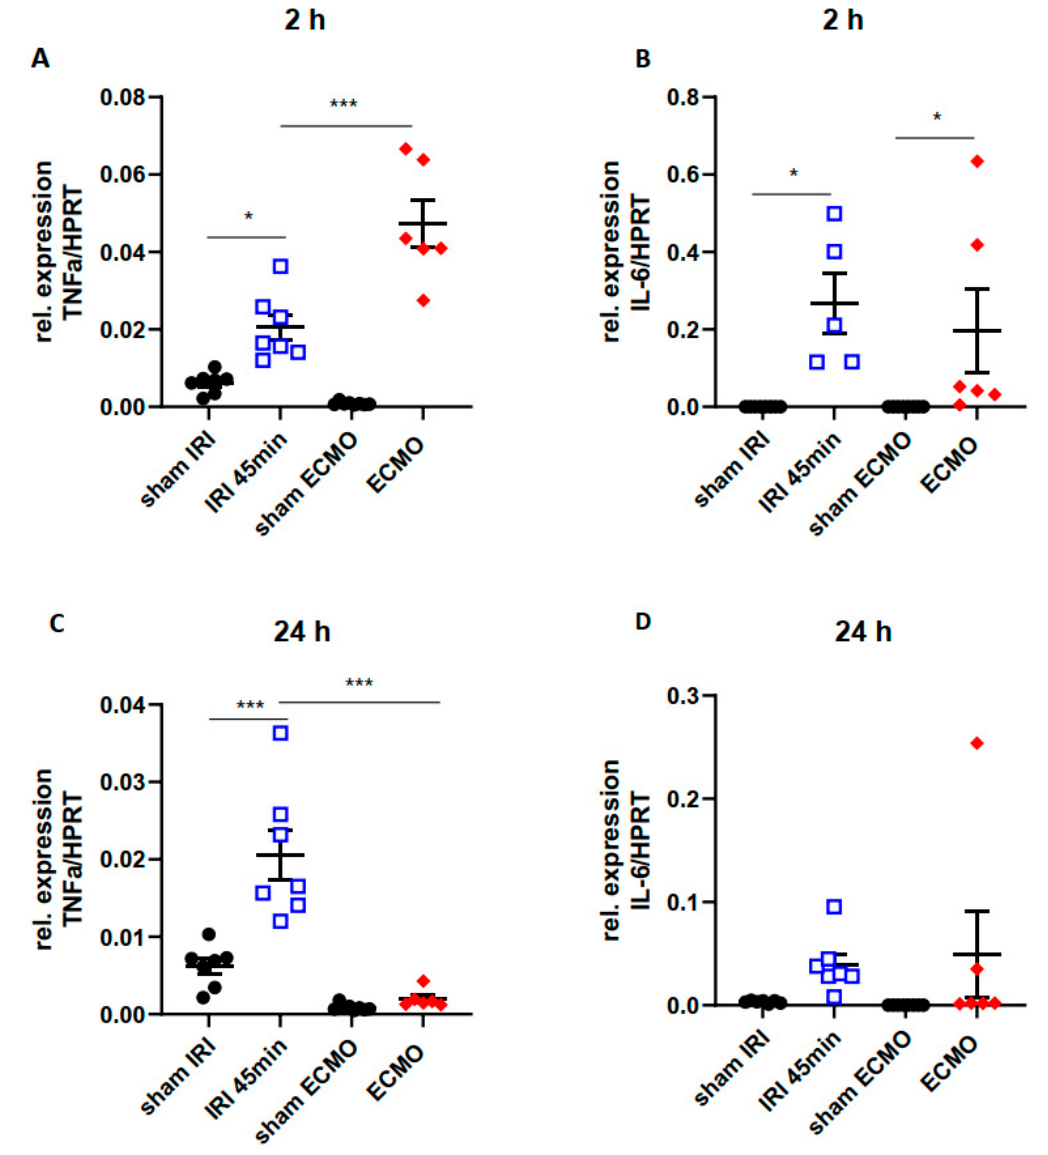
Figure 4. Pro-inflammatory cytokines in the kidney tissue 2 h and 24 h after renal IRI and ECMO. The pro-inflammatory cytokines TNF α ( A , C ) and IL-6 ( B , D ) were determined by qPCR in the renal tissue 2 h ( A , B ) and 24 h ( C , D ) after renal IRI for 45 min (blue bordered squares) and ECMO for 2 h (red diamond suits). Sham-IRI mice (opening of the abdominal cavity without manipulation of the renal vessels) and sham-ECMO mice (cannulation without connection to the extracorporeal circuit) had no significant upregulation of renal TNF α or IL-6 levels (black dots). Renal upregulation of TNF α was more pronounced 2 h after ECMO ( A ) compared with renal IRI and normalized after 24 h ( C ). In renal IRI however, TNF α expression in the kidney increased after 2 h compared with sham ( A ) and was significantly higher compared with ECMO mice after 24 h ( C ). Early enhanced IL-6 expression was observed in renal IRI and ECMO ( B ) which was decreased 24 h after both procedures ( D ). N = 5–8 mice each group are shown. * p < 0.05, *** p <